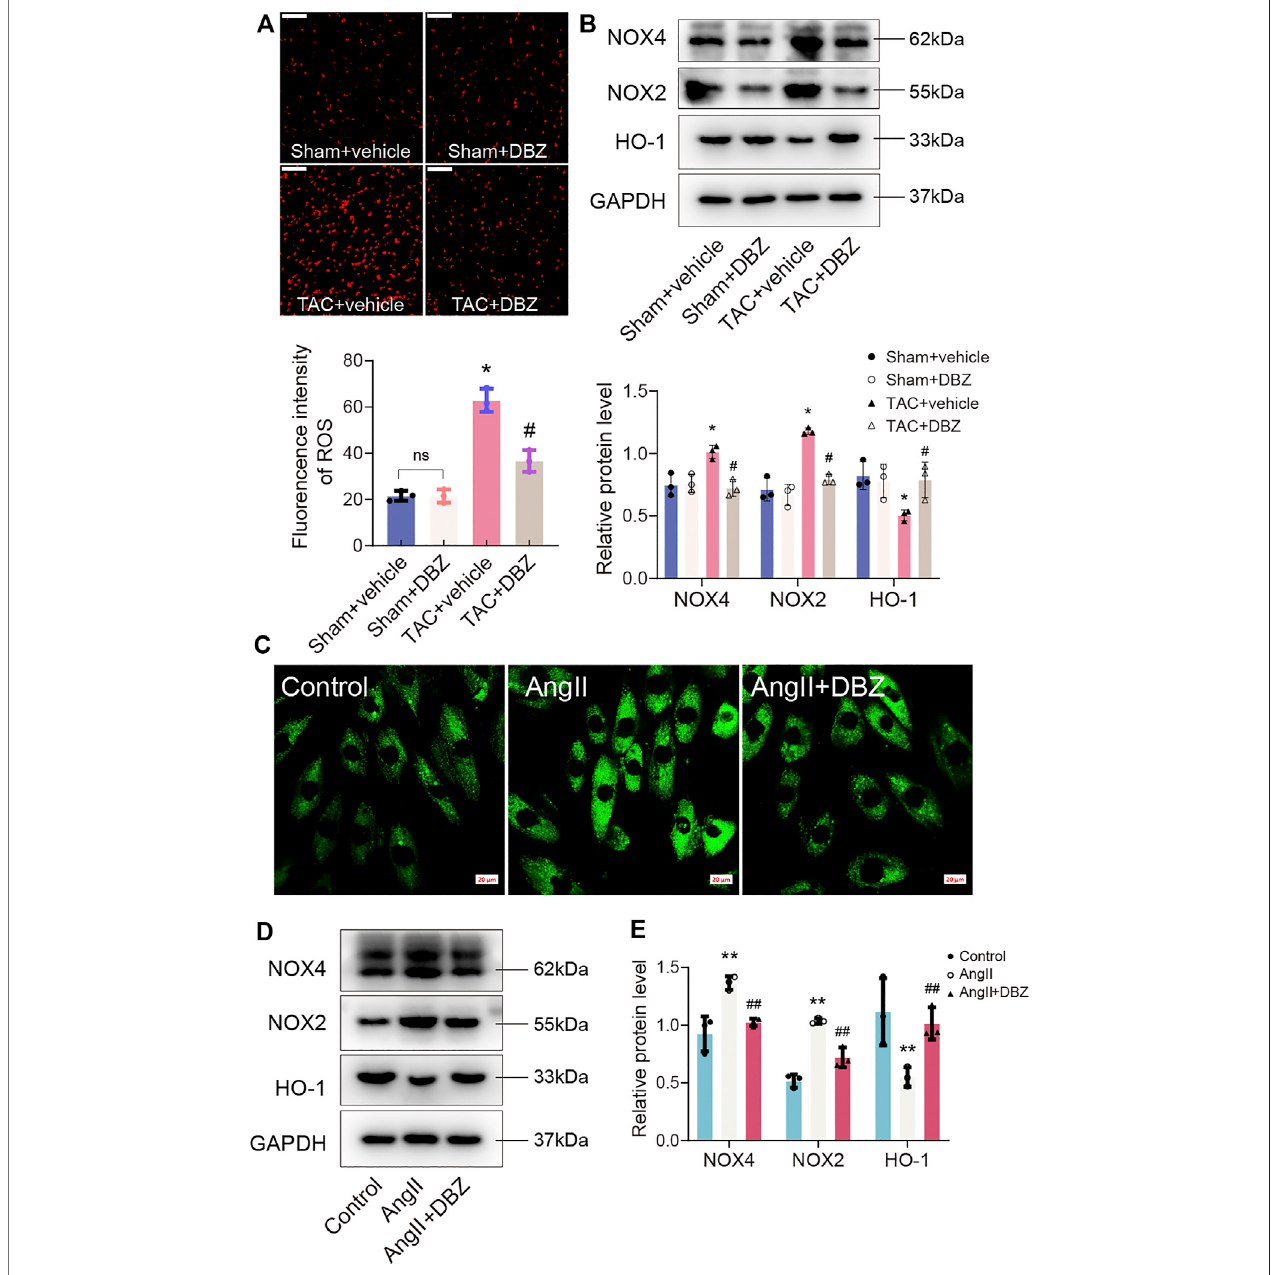
FIGURE 3 | DBZ attenuated the oxidative stress. (A) Representative images and quanti fi cation of DHE staining in transverse sections and quanti fi cation. n = 3. (B) Protein levels of NOX4, NOX2 and HO-1 were determined by Western blotting assay and quanti fi ed by densitometry. n = 3. (C) The ROS generation measured using DCFH-DA. n = 3. Scale bar = 20 μ m. (D,E) Representative Western blotting assay and quanti fi cation of NOX4, NOX2 and HO-1 expression. n = 3. * p < .05 compared with the sham group, # p < .05 compared with the TAC group, ** p < .05 compared with the control group, ## p < .05 compared with the Ang II group. Results are expressed as means ± SD. Statistical analyses were performed by one-way ANOVA followed by Bonferroni ’ s post-hoc test.